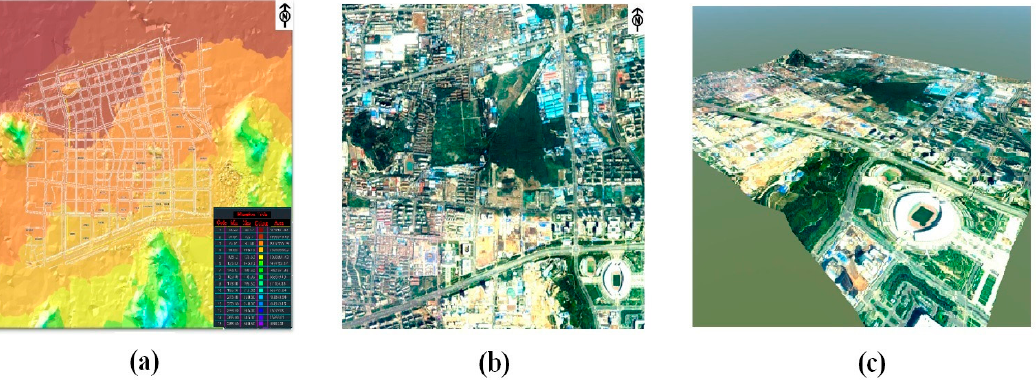
Figure 10. (a) The digital elevation model (DEM) of the project area; (b) part of aerial photograph of the project area; (c) 3D surface model.